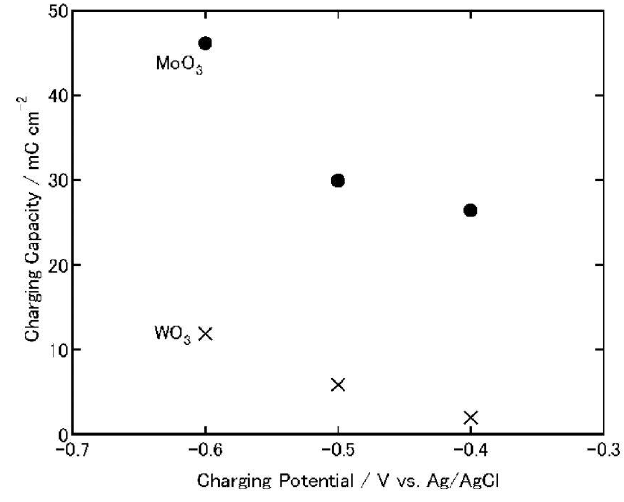
Figure 7. Charging capacities of MoO coatings are charged electrochemically (1 h) in 3 wt. % NaCl aqueous solutions (pH 5) [23]. Reproduced with permission from Elsevier, ©